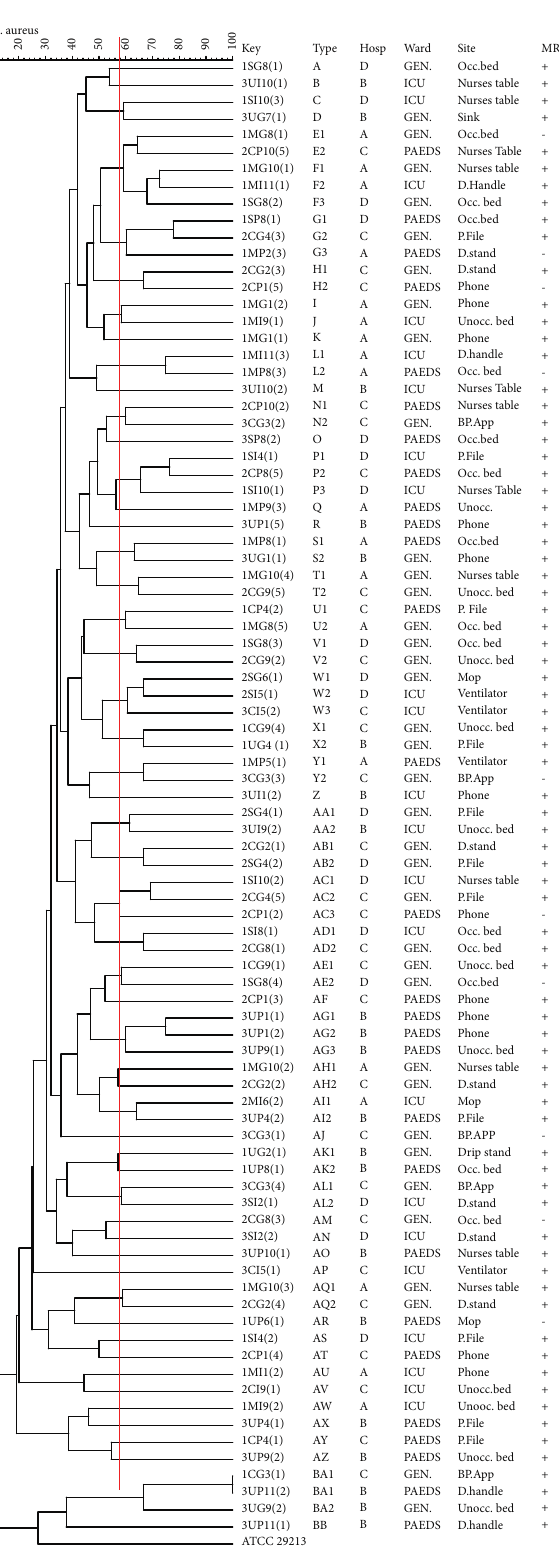
Figure 2: ERIC-PCR fingerprinting of MRSA ERIC-type groups of isolates recovered from four public hospitals in KZN, South Africa. An index of 60%, indicated by the solid red line, was used, re- spectively, to determine similarity and clustering. S. aureus ATCC 29213 was used as the quality control